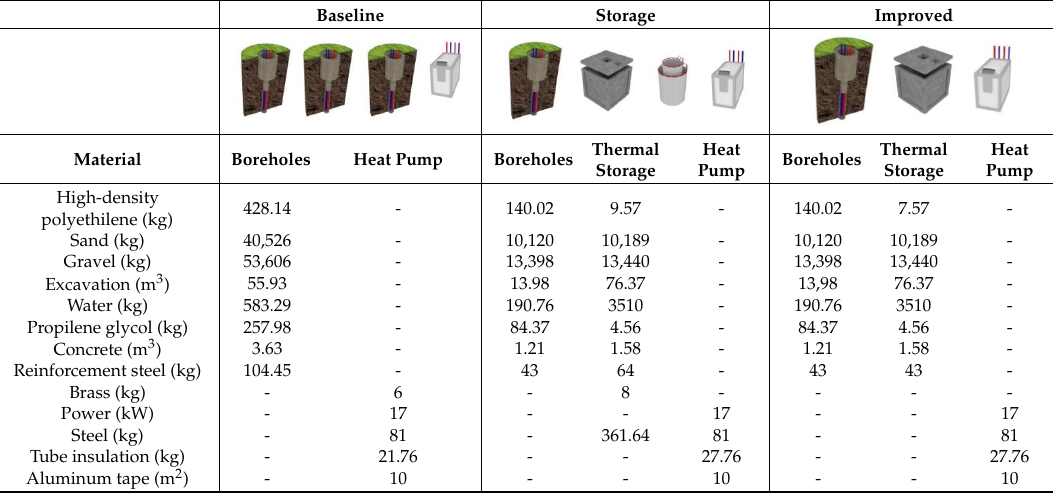
Table 1. The materials incidence of the analyzed scenarios. Baseline Storage